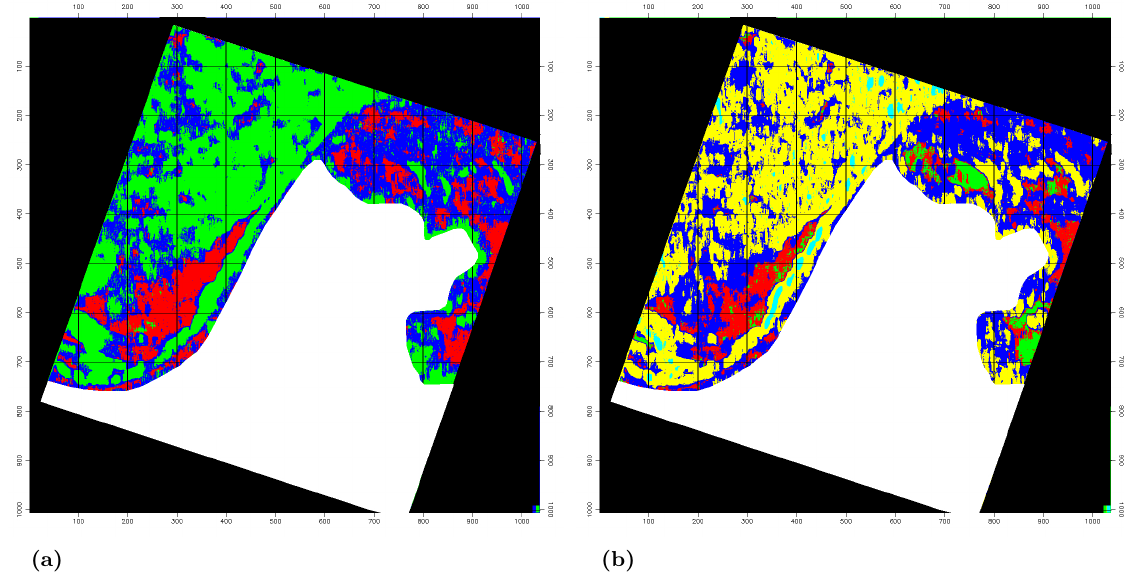
Figure 11. Sea-ice classification for ERS SAR data of Barrow area in Figure 4. Result of supervised classifications based on vario parameter maps (Figure 9a–d), using a maximum-likelihood criterion. ( a ) Result of supervised classification based on 4 parameter maps ( pond , mindist , p 1, p 2) and 3 sea-ice class types; ( b ) Result of supervised classification based on 4 parameter maps ( pond , mindist , p 1, p 2) and 5 sea-ice class types. Land areas masked for